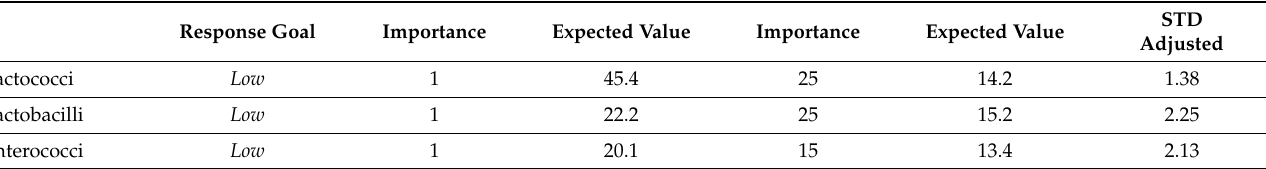
Figure 7. Design of experiment microbiota results: ( A ) lactobacilli, lactococci, enterococci and ( B ) staphylococci, Enterobacteriaceae , total coliforms, Escherichia coli and yeasts and moulds viable cell numbers in ewe milk samples after high-pressure processing (HPP) treatment according to central composite design. Empty bars represent microbial loads below the quantification limit (1.0 log cfu/mL). Table 2. Parameters considered in model optimization of the design of experiment (microbiota and yield) with response goals, with the respective different importance attributed and values expected to achieve by the modulation design at predicted optimized